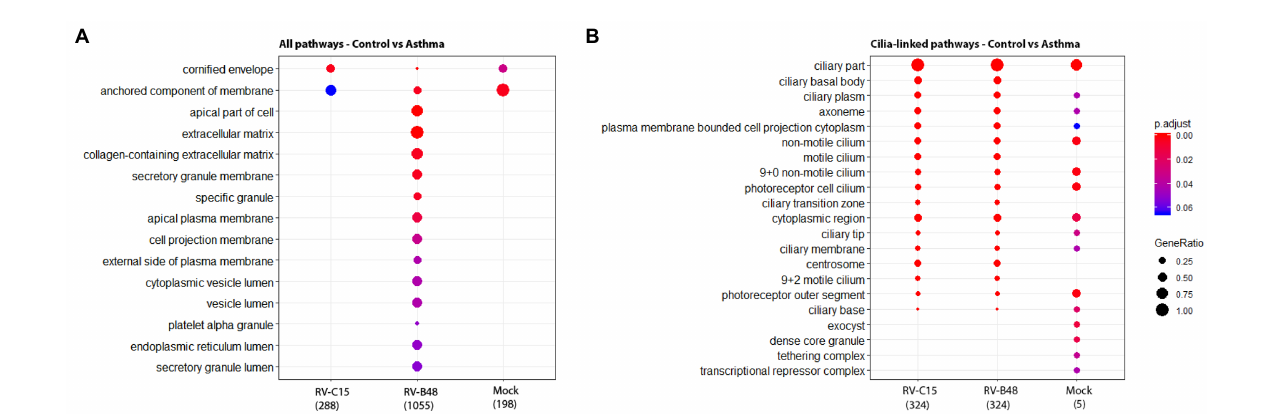
FIGURE 5 Enrichment of cellular pathways in infected and mock-infected tissues from control versus asthmatic donors. The top 15 of the most significantly enriched gene ontology cellular components analyzed from the total reads (A) and from reads of genes involved in the differentiation and function of ciliated cells (B) are shown, comparing epithelia originating from control versus asthmatic donors (Fold change >1, p < 0.05) in mock, RV-B48 and RV-C15 infections.